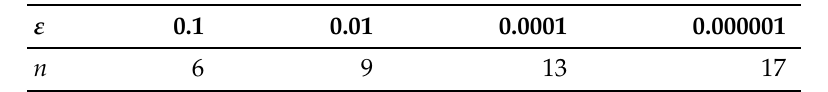
Table 2. Number of the necessary iterations needed if started with x = 5 in X to get an ε a priori error estimate.